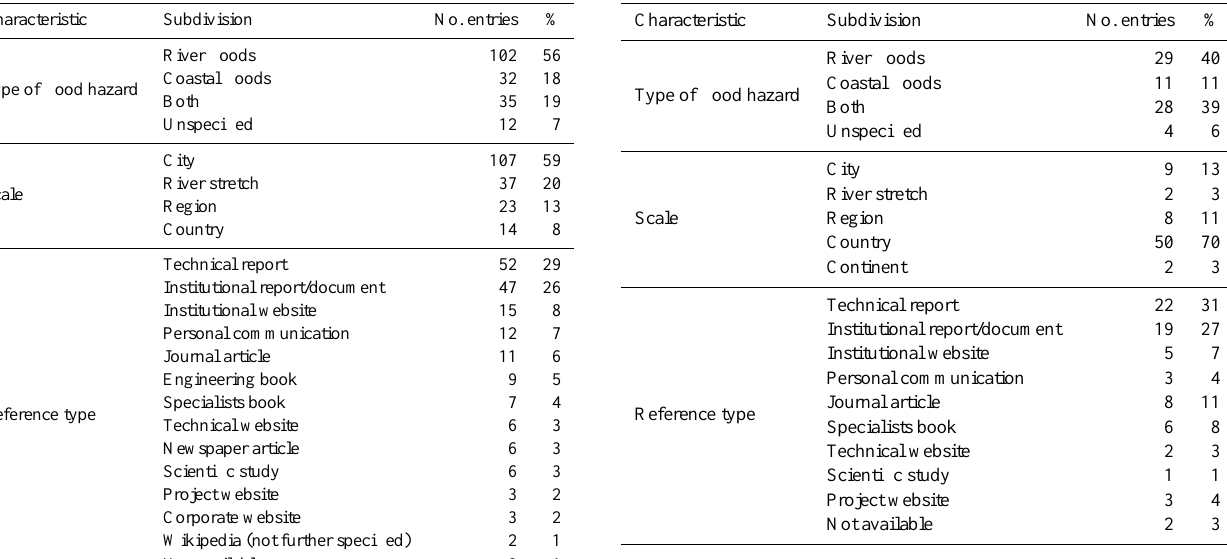
Table 2. Overview of the characteristics of information contained in the policy layer of the FLOPROS database (the full database is available in the Supplement).